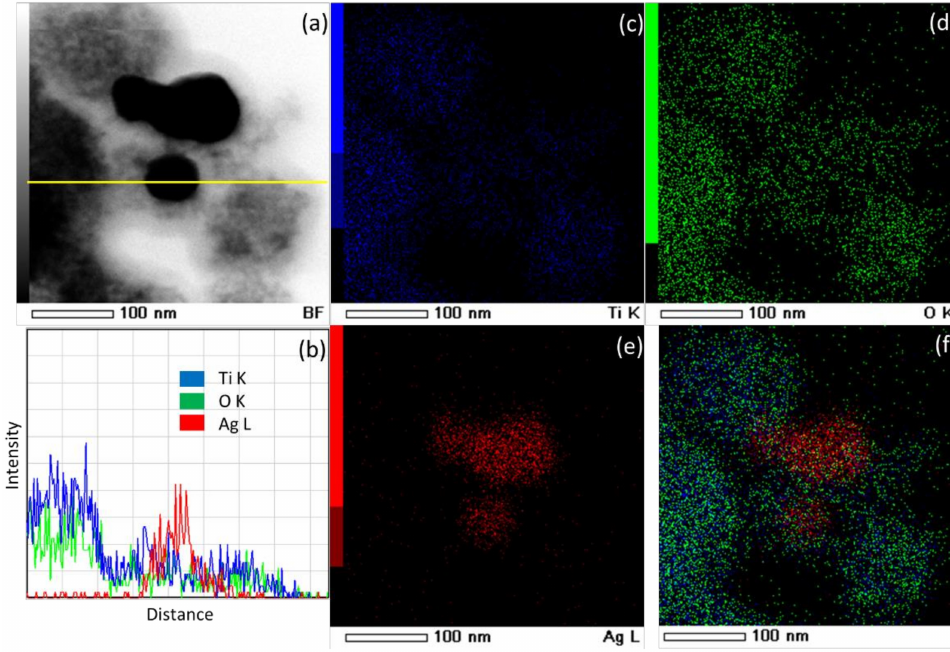
Figure 6. ( a ) STEM micrograph of the prepared photocatalyst, ( b ) EDS cross-sectional (yellow line in ( a )) elemental profiles, ( c – e ) STEM-EDS mapping images of Ti, O, and Ag, ( f ) overlay